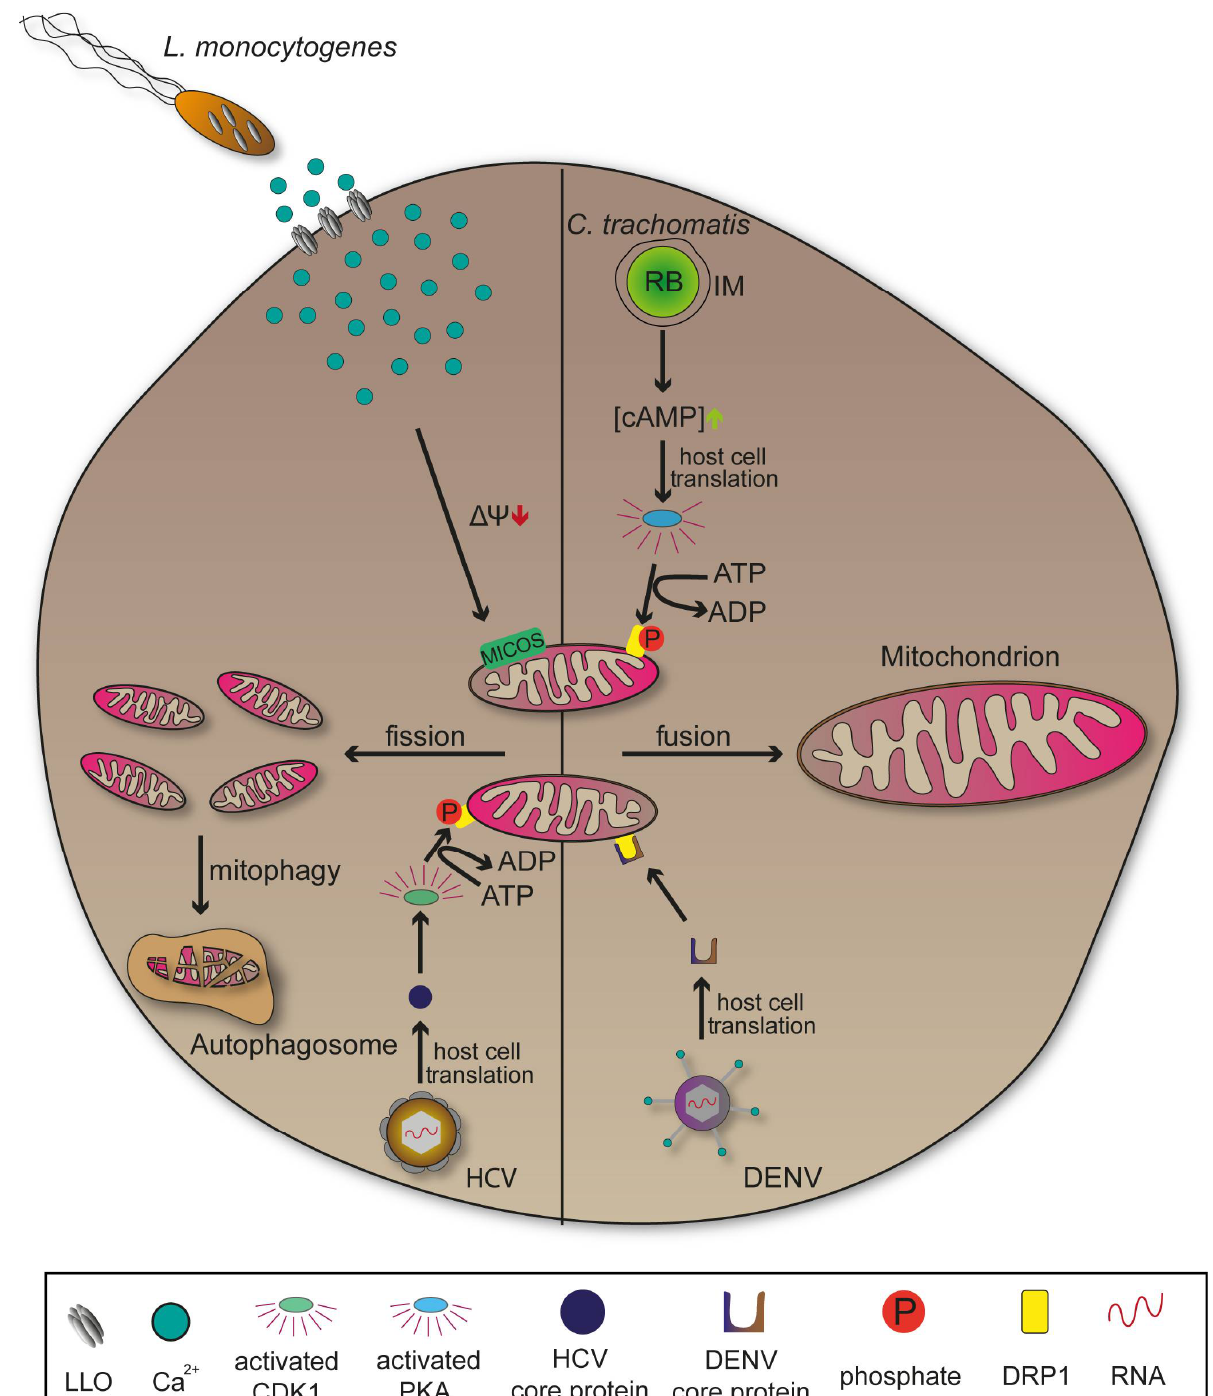
Figure 6. Manipulation of mitochondria by intracellular pathogens. Listeria monocytogenes secretes Listeriolysin O (LLO) that forms pores in the host cell plasma membrane leading to Ca 2+ influx. Subsequent decrease in mitochondrial membrane potential and mitochondrial contact site and cristae organizing system (MICOS) functionality are elemental for mitochon- drial fission. C. trachomatis exploits the host cell translation machinery to synthesize cyclic adenosine monophosphate (cAMP) enriching proteins whose consequences activate cyclic AMP-dependent protein kinase (PKA). PKA specifically phosphorylates dynamin-related protein 1 (DRP1) to inhibit its function resulting in elongated mitochondria. Dengue virus (DENV) as well inhibits DRP1 function. Hepatitis C virus (HCV) activates the DRP1 phosphorylating cyclin-dependent kinase 1 (CDK1) through core proteins ultimately promoting mitochondrial fission and mitophagy.